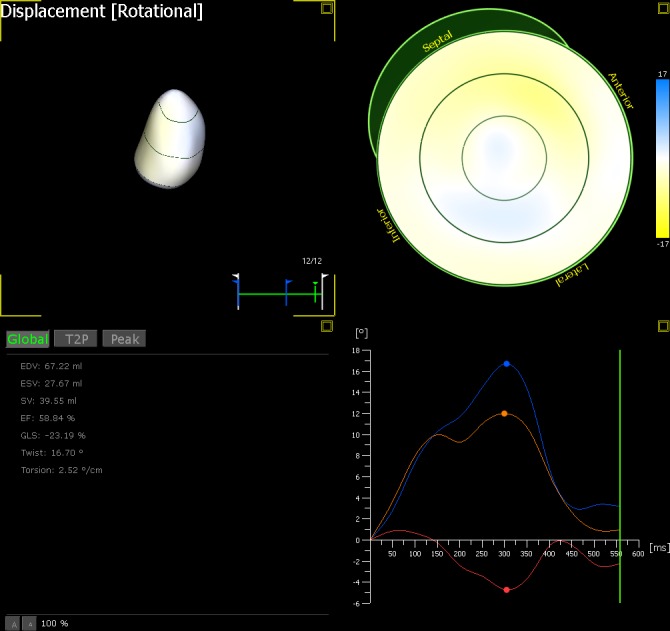
The analysis of LV rotation at apical (orange line), rotation at basal (red line) and twist (blue line) variables can be derived and displayed.